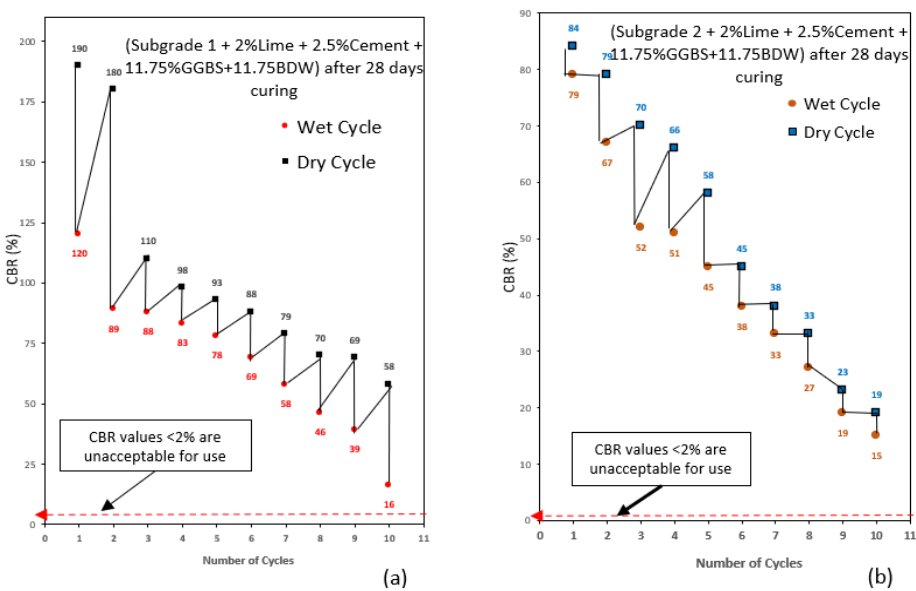
Figure 5. ( a ) Wetting – drying cycle results for subgrade 1 composed of GGBS and BDW after 28 days of curing. ( b ) Wetting – drying cycle results for subgrade 2 composed of GGBS and BDW after 28 of curing. ( b ) Wetting–drying cycle results for subgrade 2 composed of GGBS and BDW after 28 days days of curing. of